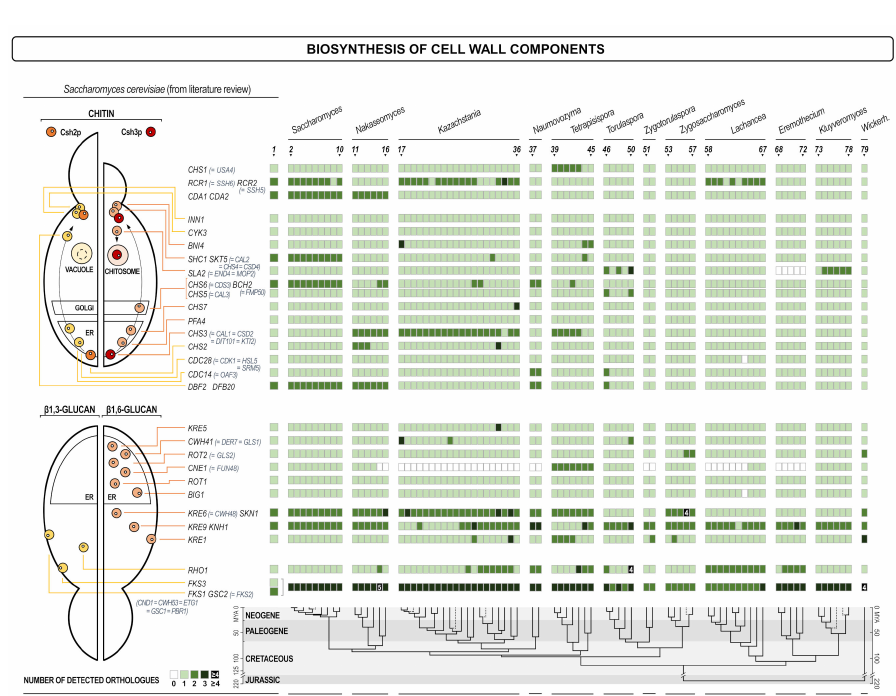
Figure 2. Heat map of orthologues of S. cerevisiae genes involved in the synthesis of cell wall polysaccharides. Every gene is presented in one row, while every yeast (see the legend of Figure 1) is presented in one line. The scheme of the cellular process with the site in which the product of each gene is involved is shown on the left. The intensity of the color of every square is proportional to the number of orthologues found as depicted in the inset legend. White square means no orthologue has been found. The lower part of the figure presents the evolutionary chronogram of each species.